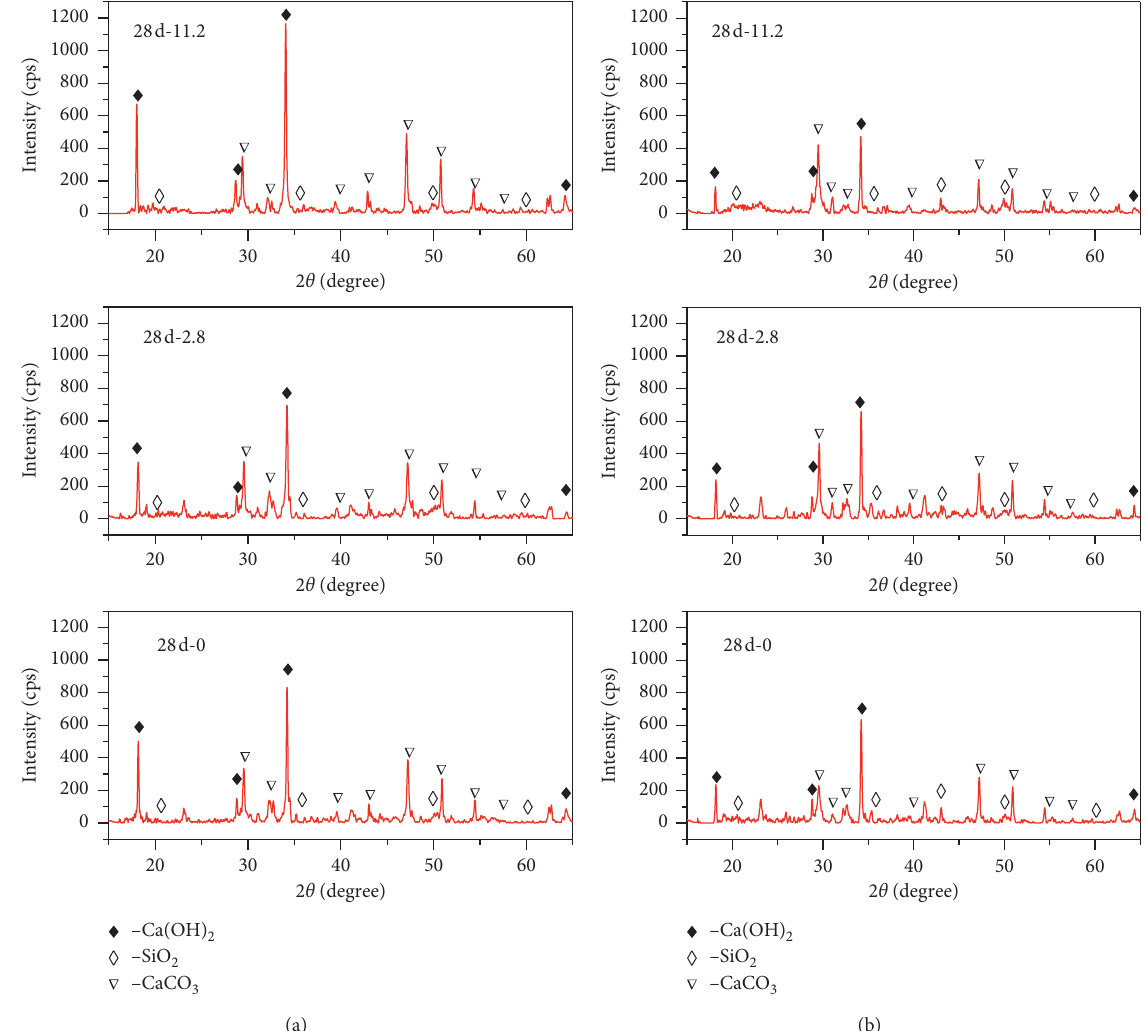
Figure 4: XRD of 28d leaching of specimens at different flow rates: (a) OPC; (b)